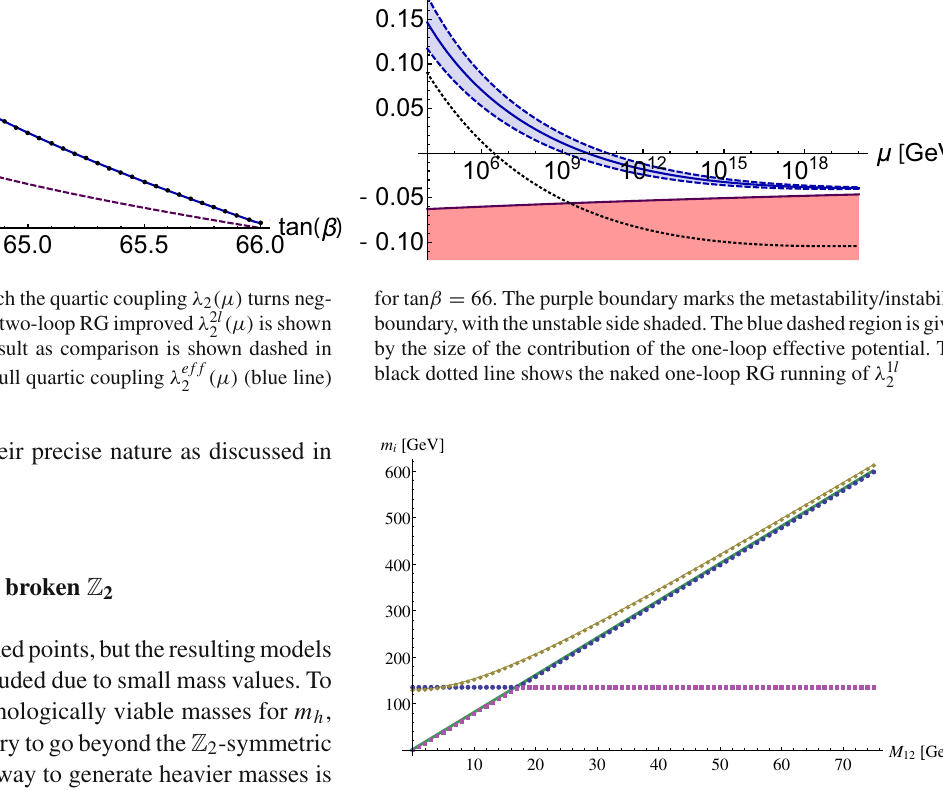
Fig. 6 Higgs boson masses for a softly broken Z 2 -symmetry for tan β = 64 against M 12 in GeV for the vacuum-unstable branch of solutions. The masses shown correspond to the CP-even scalars m h , m H (violet squares, blue circles), the charged Higgs m H + (yellow dia- monds) and the pseudoscalar m A (green